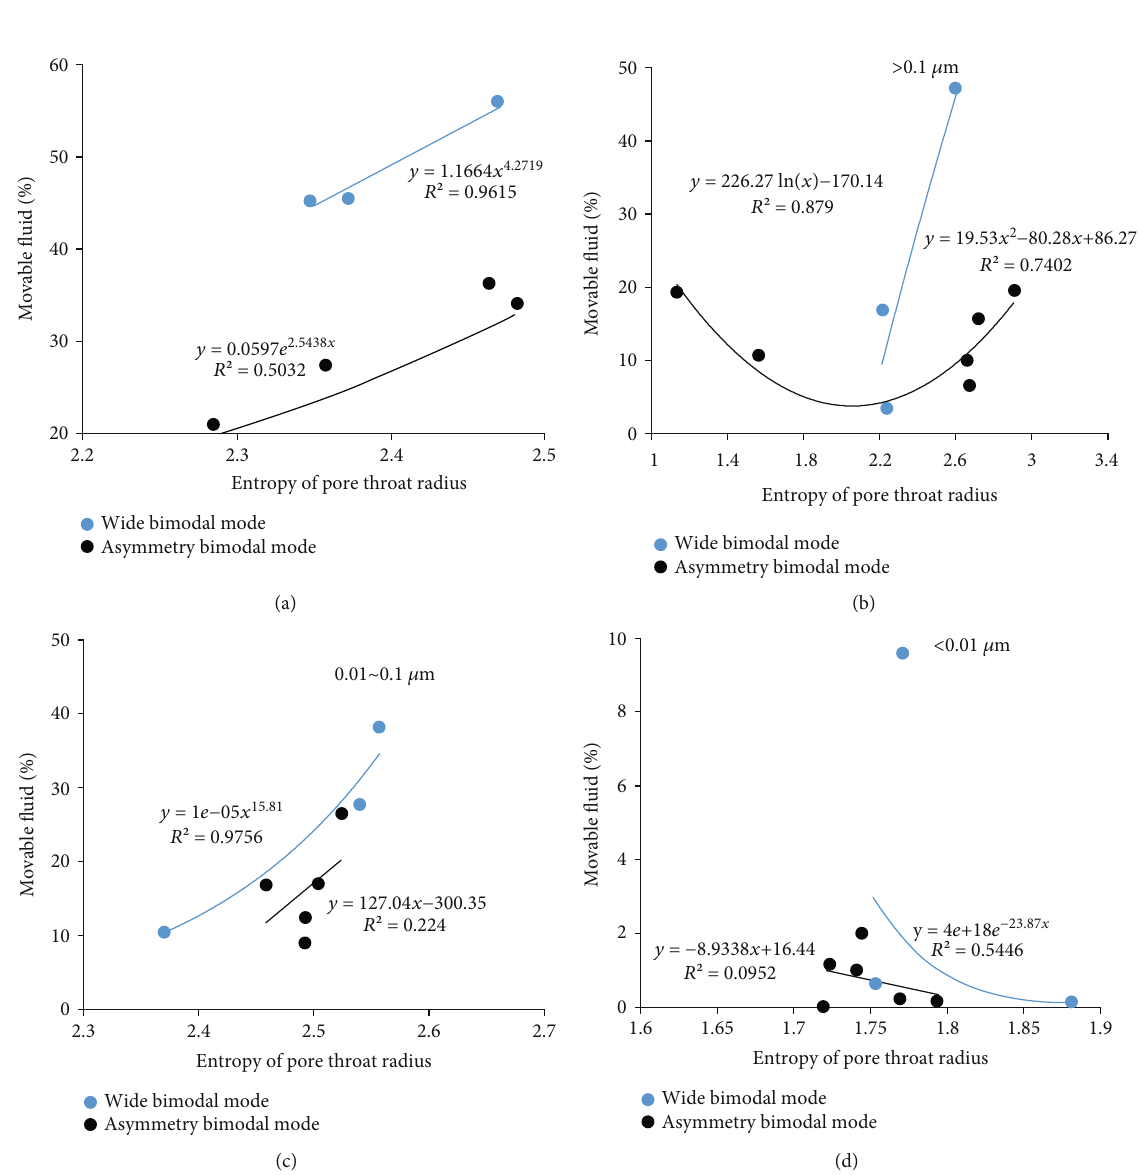
Figure 5: The relationship between the entropy of the pore throat radius and the movable fl uid